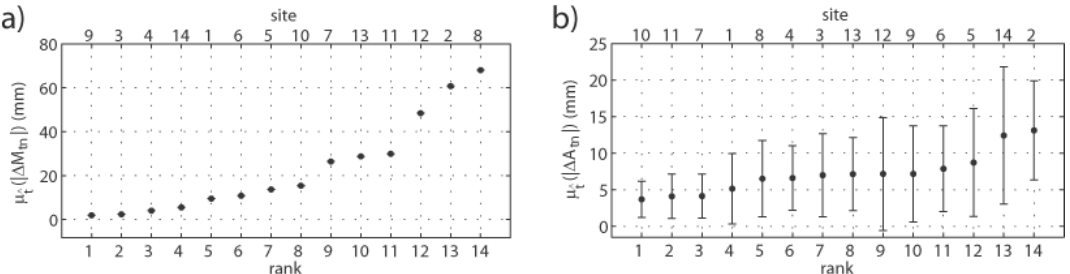
( | 1M tn | ) ), and (b) the temporal mean of the absolute values of b t